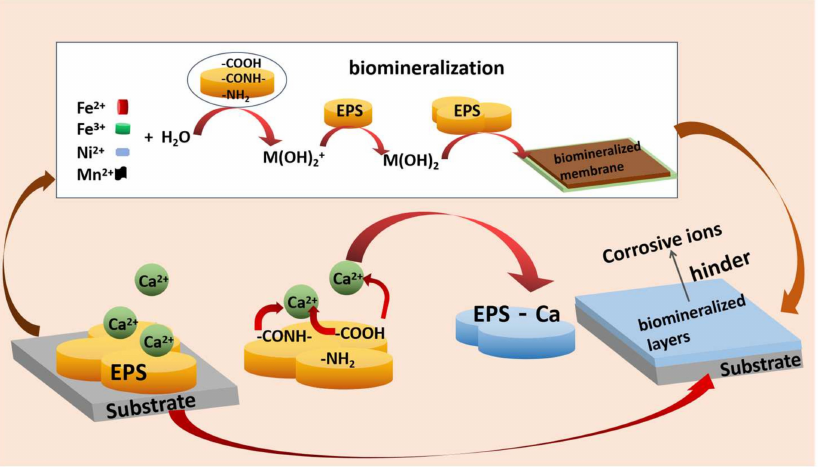
Figure 6. Diagram of formation of a biomineralized film. Adapted from [56]. Reproduced with permission from